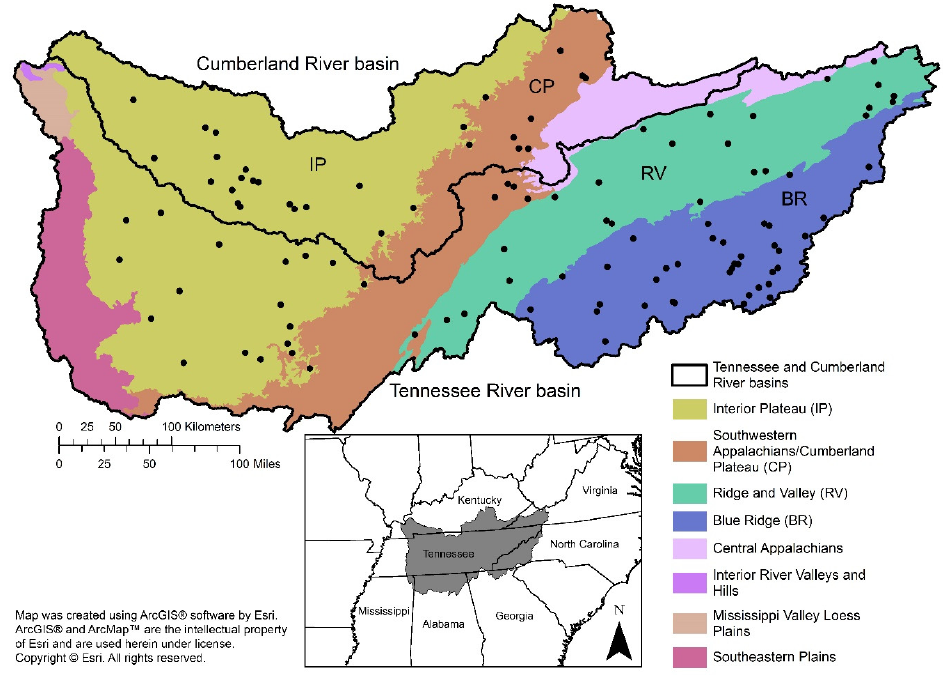
Figure 1. Distribution of selected stream sites within Level III ecoregions of the Tennessee and Cumberland River basins.